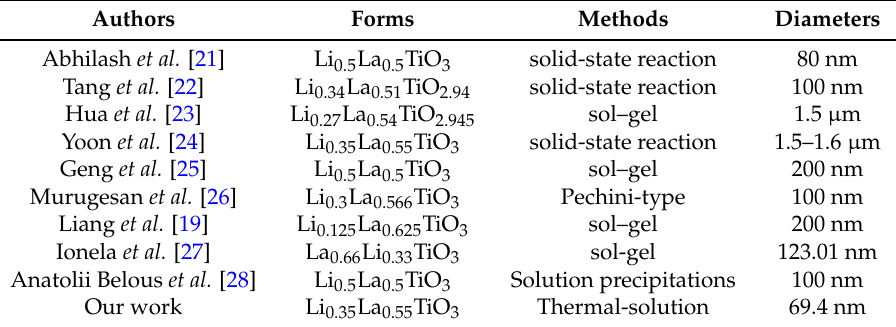
Table 1. LLTO particles prepared by various methods.